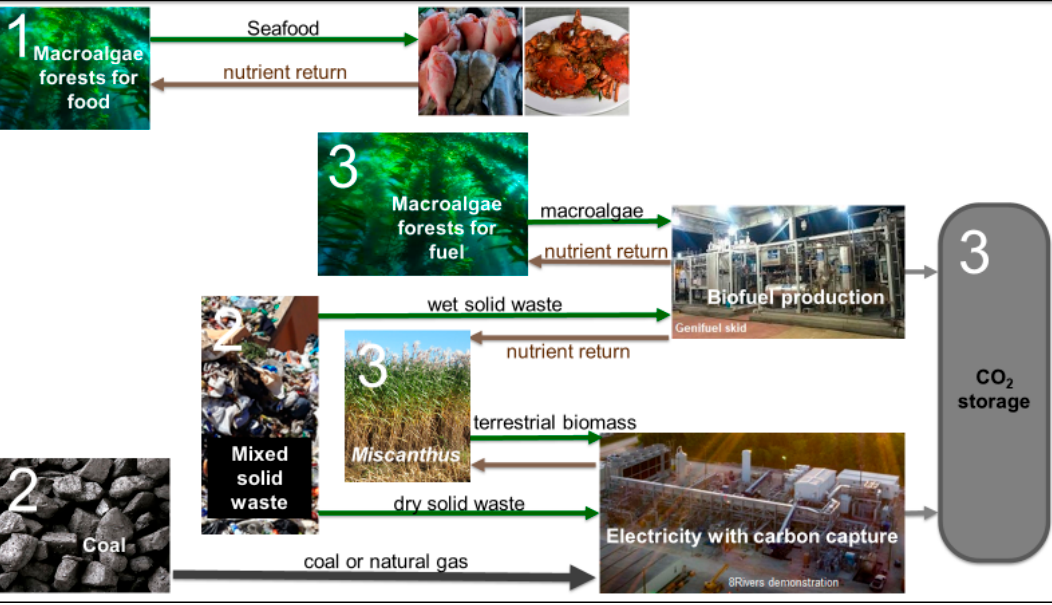
Figure 1. Initial technologies to achieve SDGs while restoring 300 ppm CO 2 . Gray arrows represent liquid CO 2